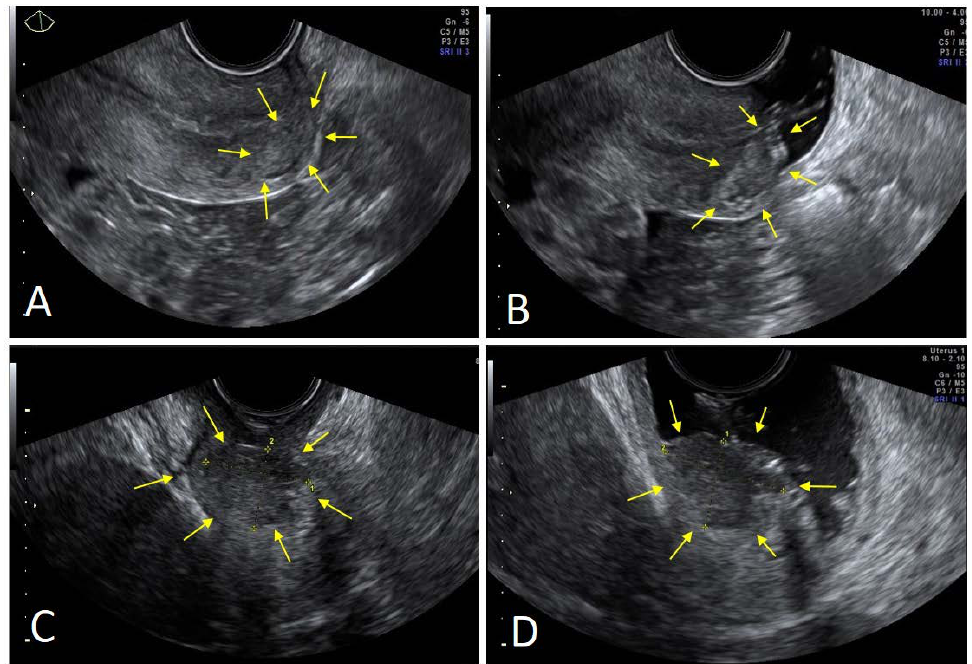
Figure 2. Echogenicity by TVUS and VGS. ( A ) Small adenocarcinoma (arrows) at TVUS; ( B ) the same tumor at VGS, with better definitions of the margins and more hyperechoic echogenicity (arrows). ( C ) Squamous tumors (arrows) at TVUS; ( D ) the same tumor at VGS, with better definitions of the margins and more hypoechoic echogenicity (arrows). When the stromal infiltration was analyzed, there was a good concordance between histology and VGS, with a sensitivity of 89% (95% CI 0.44–0.83), a specificity of 89% (95% CI 0.52–0.86), and a Cohen’s kappa of 0.78. When the stromal invasion was >2/3, the his- tological exam identified five of six (83.3%) cases with positive lymph nodes (6), while VGS predicted four cases (66.6%).